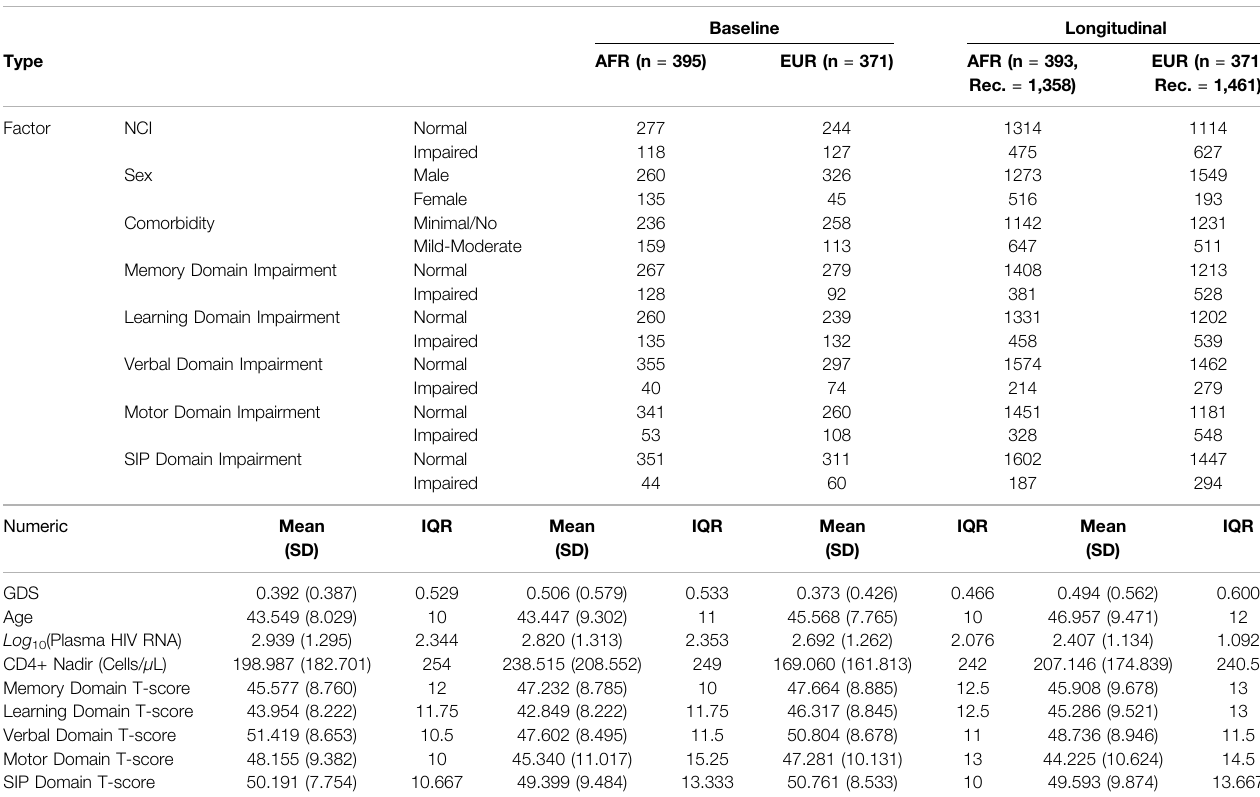
TABLE 1 | Summary of study variables.